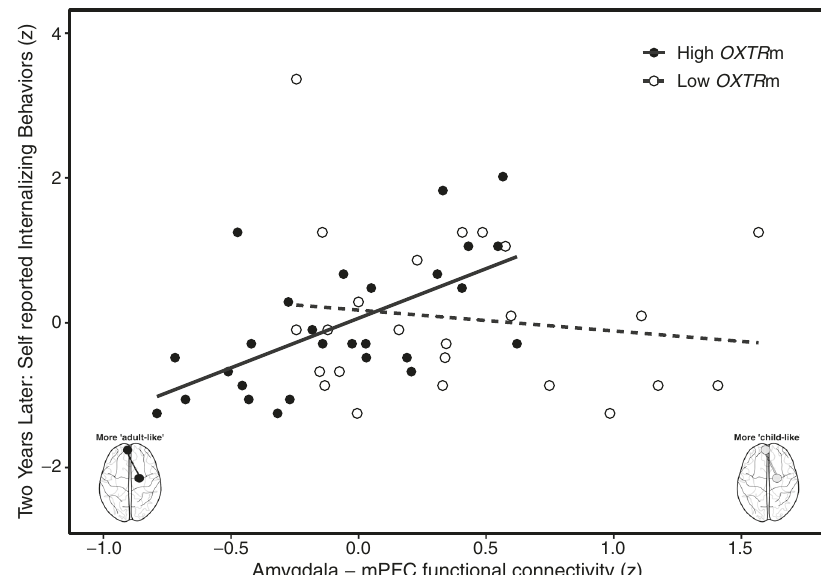
Fig. 3 Amygdala – mPFC functional connectivity and OXTR m are predictive of children ’ s self-reported internalizing behaviors 2 years later. For visualization purposes, plotted is the raw data for the interaction of functional connectivity and a median split of OXTR m. The full Bayesian model utilized continuous variables. Individuals with higher OXTR m (black dashed line) are more sensitive to the association between amygdala – mPFC functional connectivity and internalizing behaviors compared to individuals with low methylation (solid